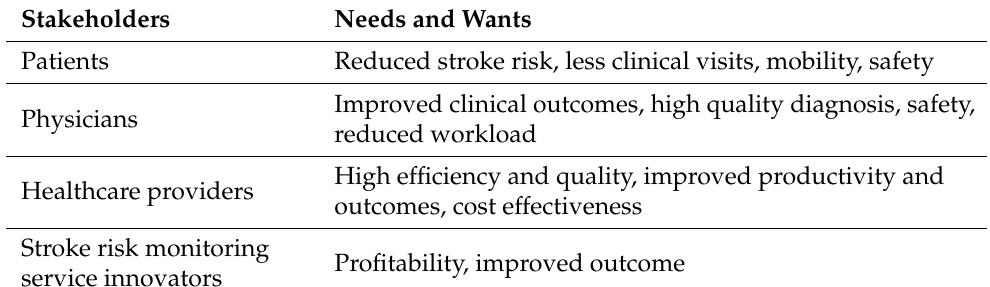
Table 1. Stakeholders’ AF detection service with hybrid decision support.